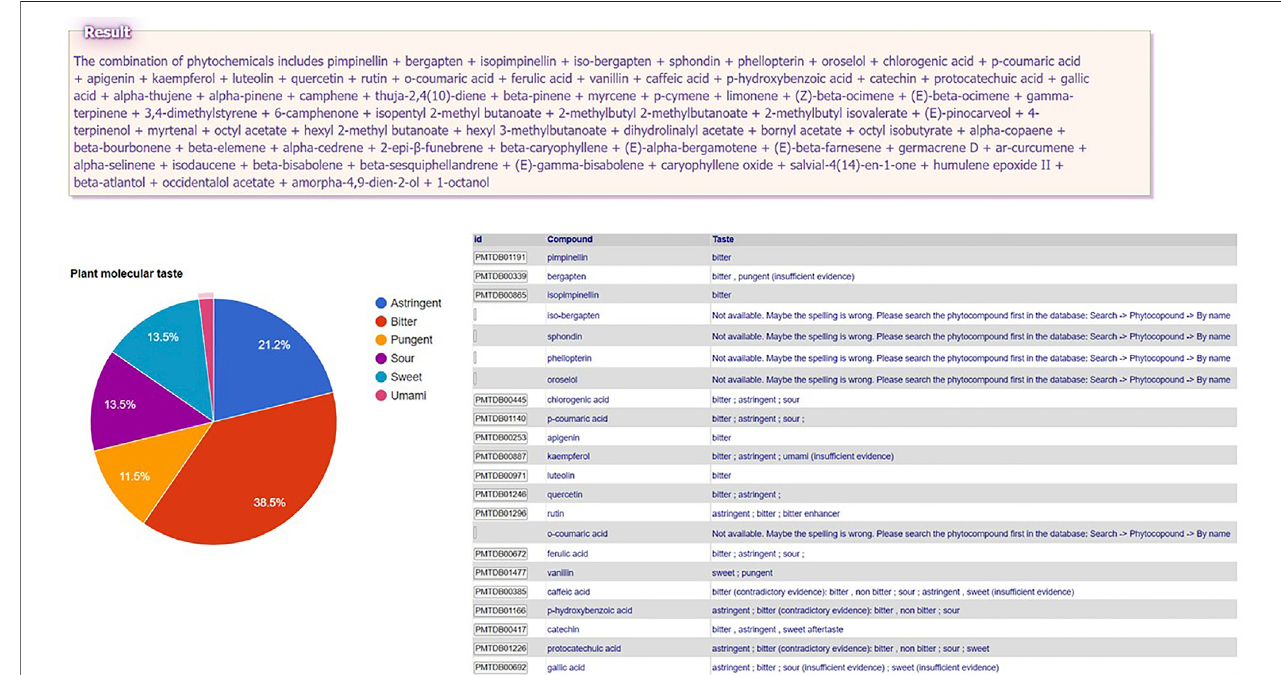
Frontiers in Pharmacology |